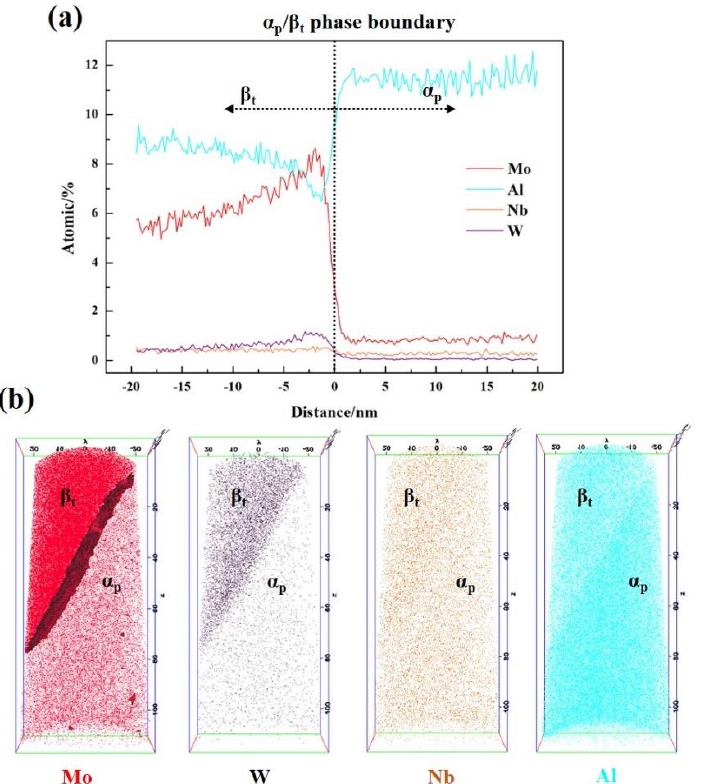
Figure 6. 3DAP results from HBA sample: ( a ) The distribution of Mo, W, Nb and Al in β t and α p ; ( b ) 3DAP maps (40 × 40 × 100 nm) of Mo, W, Nb and Al atoms.